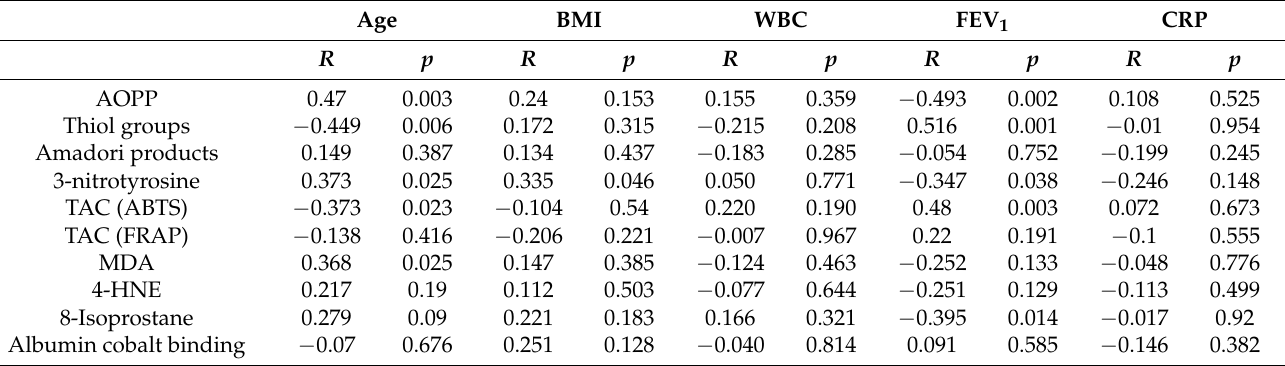
Table 5. Spearman’s rank correlation coefficients and p values between oxidative stress parameters and general characteristics of patients a